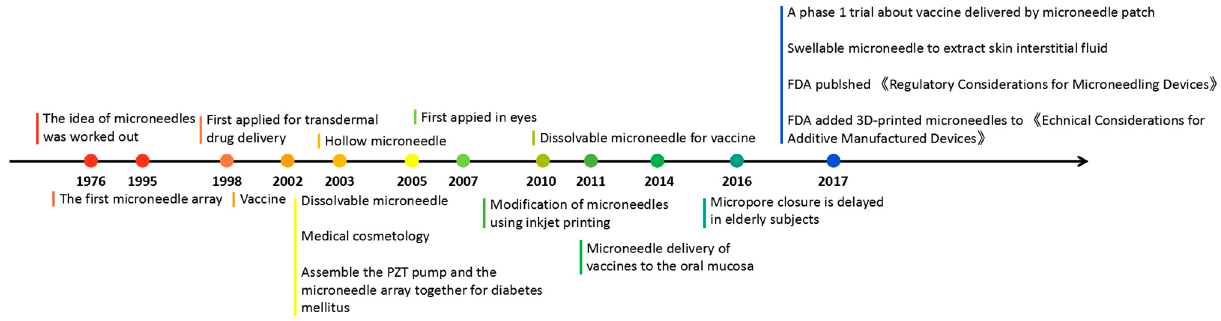
Figure 2. Timeline of microneedle development. The time point listed represented the important events associated with microneedles from the idea of microneedles in 1976.